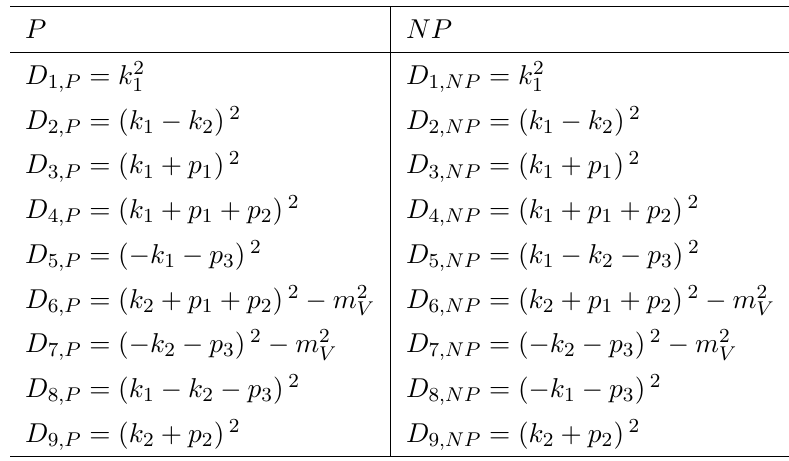
Table 2 . Propagator sets for the scalar topologies in gg → Hg . External momenta are denoted by p i and loop-momenta by k i , where p 2 masses m Z or m W .